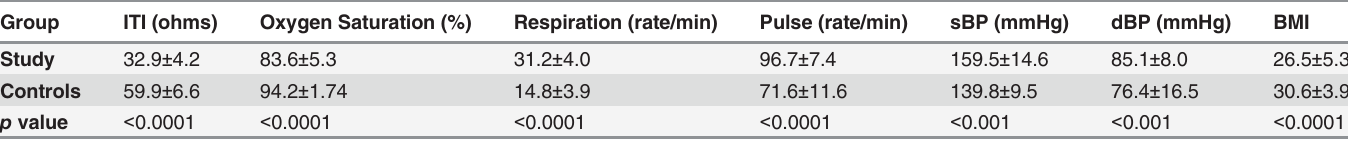
Table 1. Baseline ITI, oxygen%, RR, pulse, sBP, dBP, and BMI measurements of the study